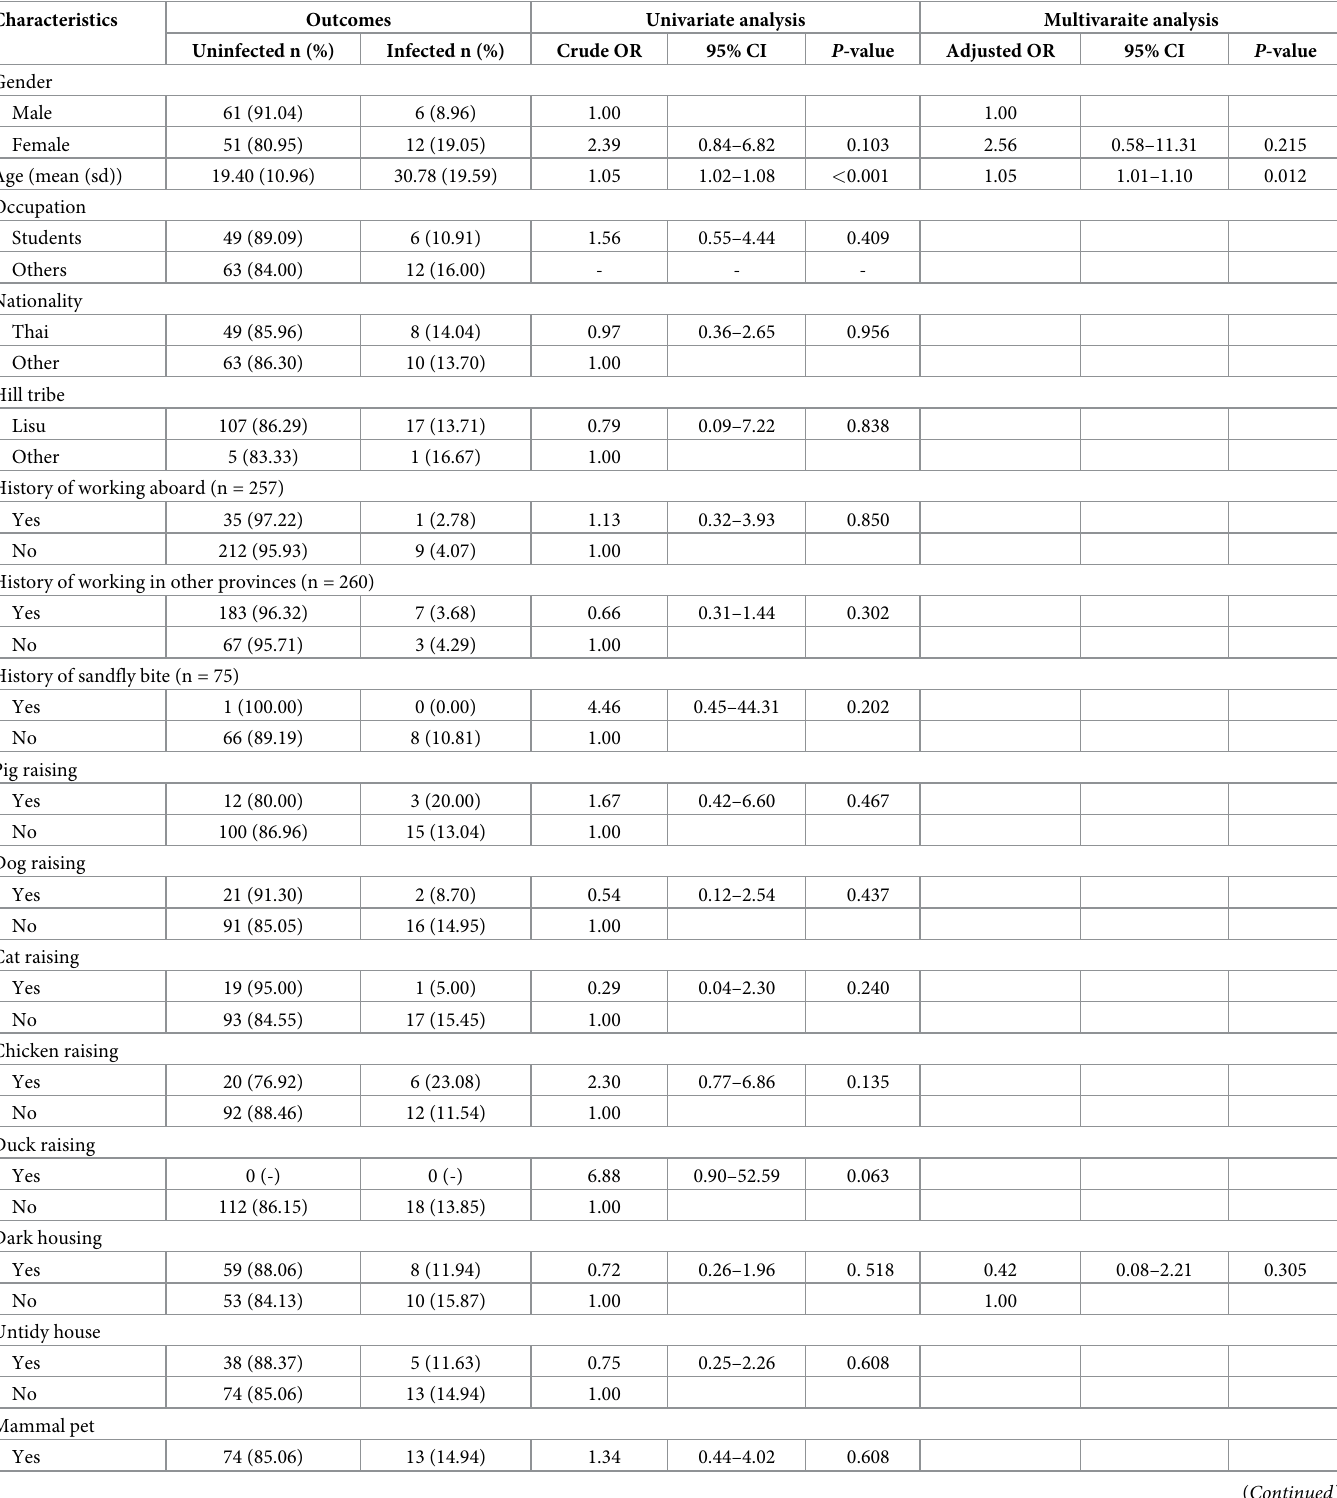
Table 4. Univariate and multivariate analysis of risk factors of Leishmania infection among patients in Amphoe Wiang Kaen District, Chiang Rai, Thailand (n = 130).